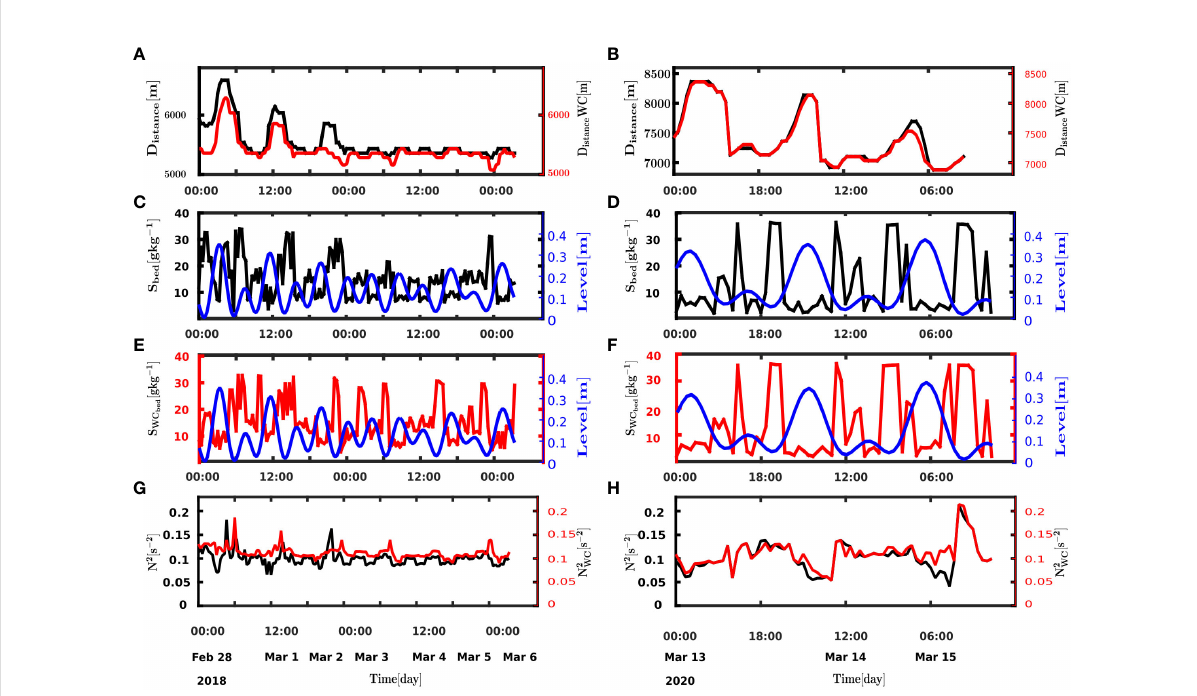
FIGURE 9 Temporal variation in saline intrusion length the dry season 2018 (A) and 2020 (B) with (red) and without (black) wave interaction. Water level and mean salinity at the salt front (averaged over the last 200 m of the salt wedge, with the salt wedge boundary set at 2 gkg-1) without wave interaction for the 2018 dry season (C) and the 2020 dry season (D) and with wave interaction 2018 dry season (E) , and 2020 dry season (F) . Averaged buoyancy frequency at the salt front the 2018 dry season (G) and the 2020 dry season (H)